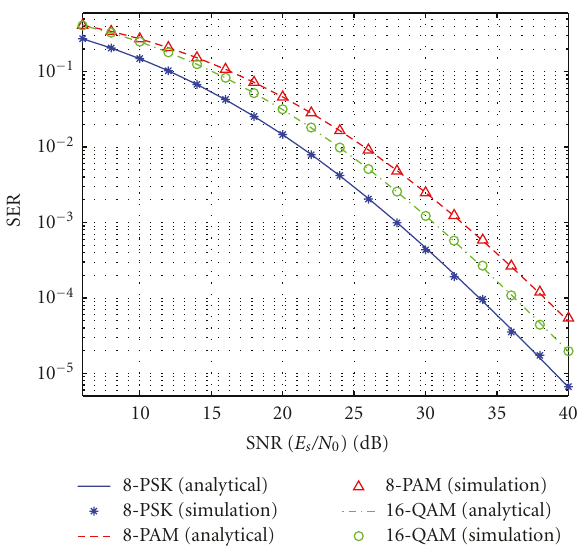
Figure 3: Comparison of SER computed using analytical expres- sions (21), (22), and (23) with the estimates obtained by system simulation. Results obtained with a 4 × 2 MIMO system (without precoding) based on rate 3/4 OSTBC C 4 from [20] and the exponential antenna correlation model.